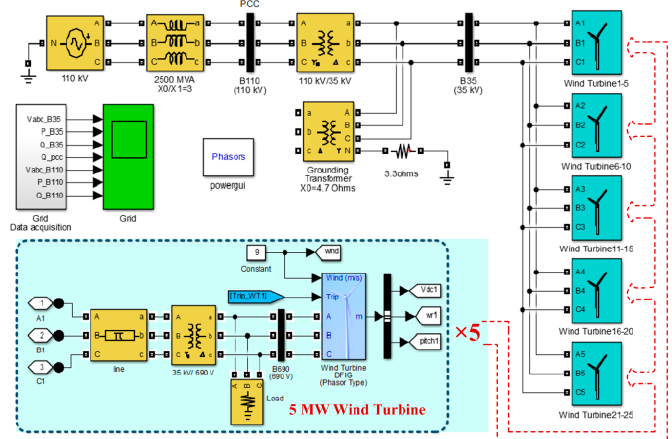
Figure 7. A screenshot of the WF structure in the simulation.